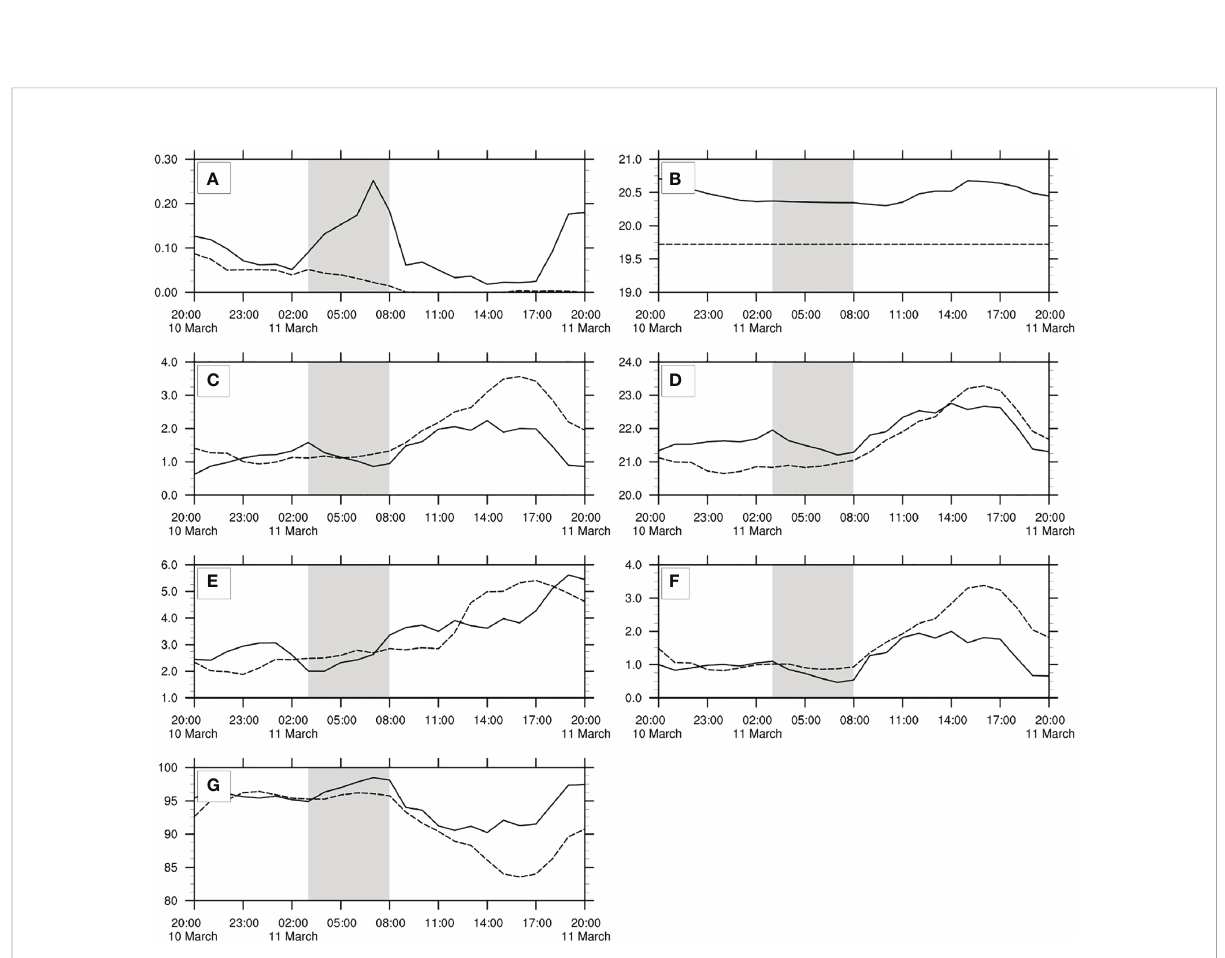
FIGURE 8 Temporal evolution of (A) LWC (g·m -3 ), (B) SST ( ℃ ), (C) ASTD ( ℃ ), (D) 2 m air temperature ( ℃ ), (E) wind speed (m·s -1 ), (F) ADTD ( ℃ ), and (G) 2 m relative humidity (%) average value over the target area (marked by the black rectangular frame in Figure 7) by using the coupled (solid line) and uncoupled (dashed line)